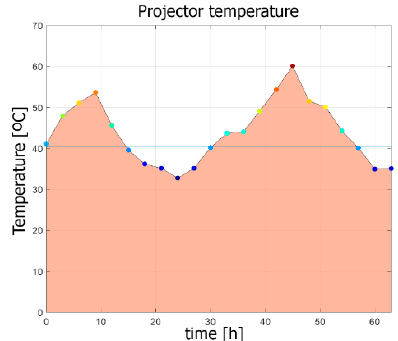
Figure 10. Projector temperature during the tests in the thermal chamber. The horizontal blue line indicates the reference temperature T ref = 42 ℃ .